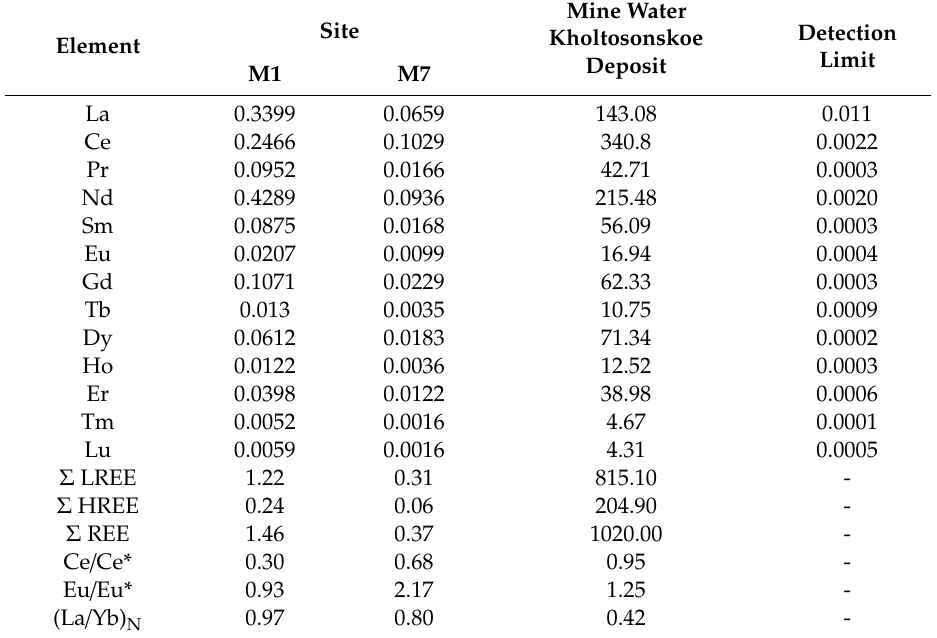
Table 6. The mean concentration REEs in the upper part (site M1)and mouth (site M7) of the Modonkul river and the mine of the Kholtosonskoe deposit ( µ g · L − 1 ), n = 15 number of samples. Site Element